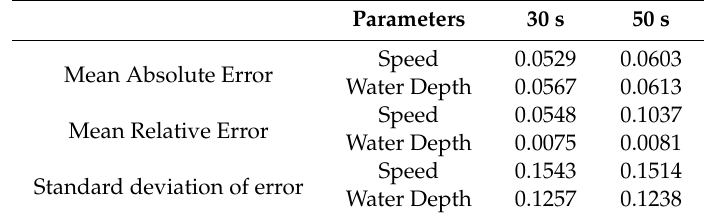
Table 2. Error analysis for the wet case.